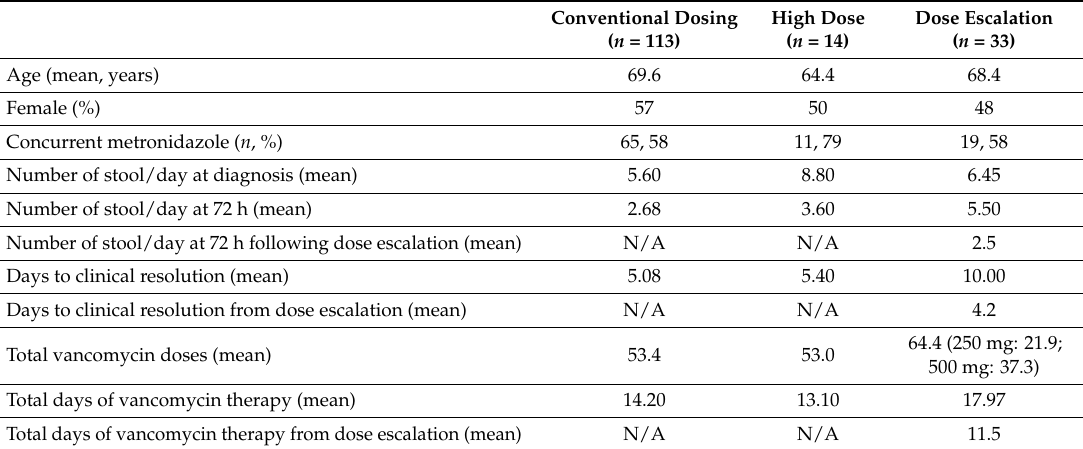
Table 1. Oral vancomycin regimens for C. difficile diarrhea.